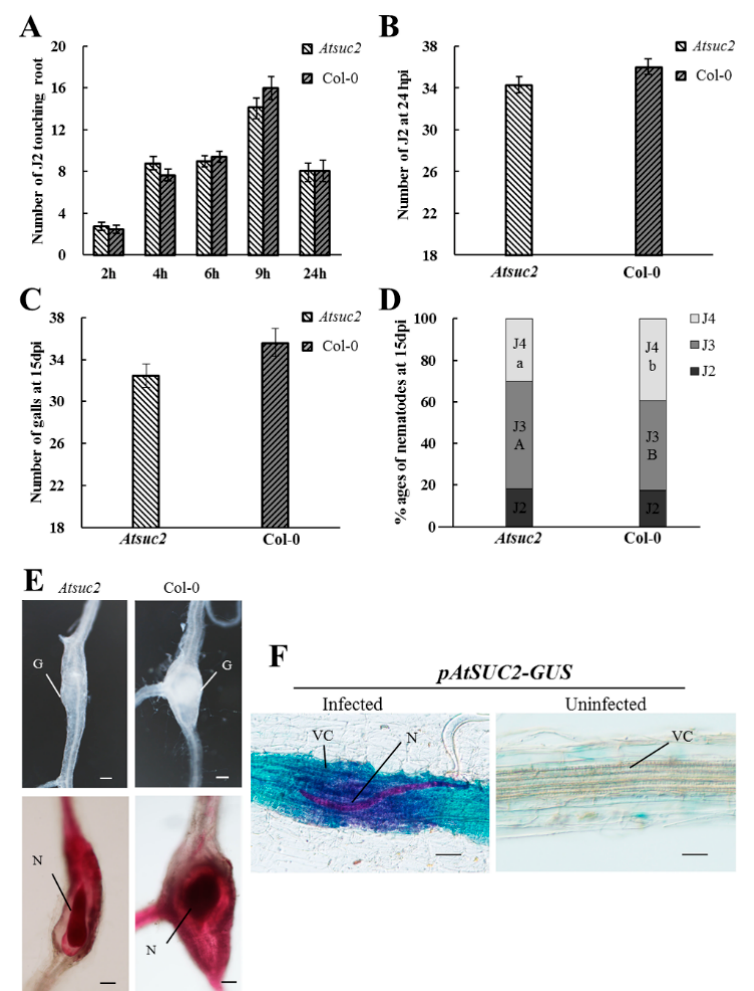
Figure 6. Response of Arabidopsis thaliana suc2 mutants and wild-type Col-0 plants to Meloidogyne incognita infection. ( A ) Second-stage juveniles (J2s) touching the terminal 7 mm of the root of the Atsuc2 mutant and wild-type Col-0 plants were counted at 2, 4, 6, 9, and 24 h in Pluronic F-127 gel ( n = 20); ( B ) Number of nematodes inside the roots of the Atsuc2 mutant and wild-type Col-0 plants at 24 h post-inoculation (hpi) ( n = 30); ( C ) Number of galls at 15 days postinoculation (dpi) ( n = 30); ( D ) Percentage of nematodes corresponding to different developmental stages (J3, third-stage juvenile; J4, fourth-stage juvenile) in the Atsuc2 mutant and wild-type Col-0 at 15 dpi ( n = 30). Different letters indicate statistically significant differences when compared with the wild-type Col-0. ( A ) or ( B ) indicate significant differences in the J3 stage; a or b indicate significant differences in the J4 stage; ( E ) Galls and acid fuchsin-stained nematodes in the Atsuc2 mutant and wild-type Col-0 plants. G, gall; N, nematode. Scale bars = 50 µ m; ( F ) GUS activity was observed in vascular cylinders at 24 hpi. N, nematode; VC, vascular cylinder. Scale bars = 50 µ m. Data represent the means ± SE. The data of plants in each experiment were analyzed using a t -test for independent samples ( p < 0.05). Similar results were obtained when these experiments were performed in duplicate. SE, standard error.